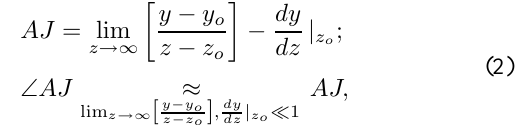
Fig. 2. Transition of CG trajectory into free